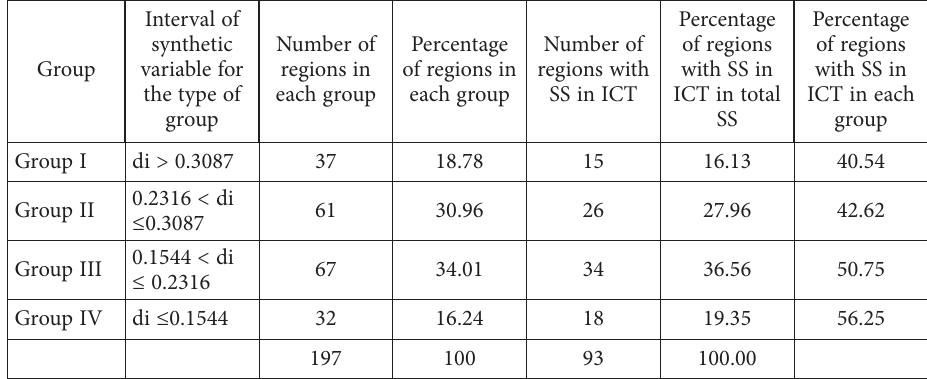
Table 4. Groups of regions in terms of readiness to application of ICT as GPT and number of regions prioritising ICT by group (2018) (source: authors) Interval of Percentage Percentage synthetic Number of Percentage Number of of regions of regions Group variable for regions in of regions in regions with with SS in with SS in the type of each group each group SS in ICT ICT in total ICT in each group SS